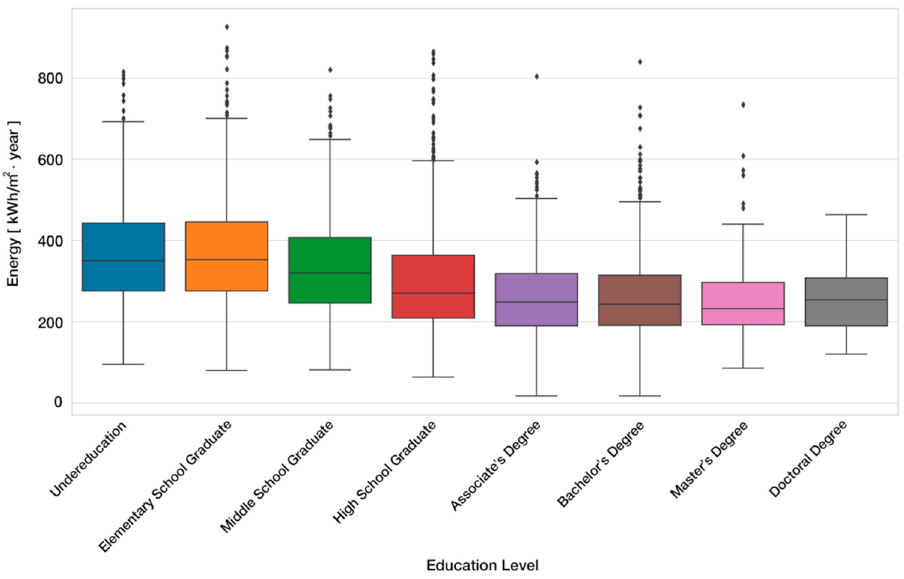
Figure 12. Comparison of energy consumption according to level of education